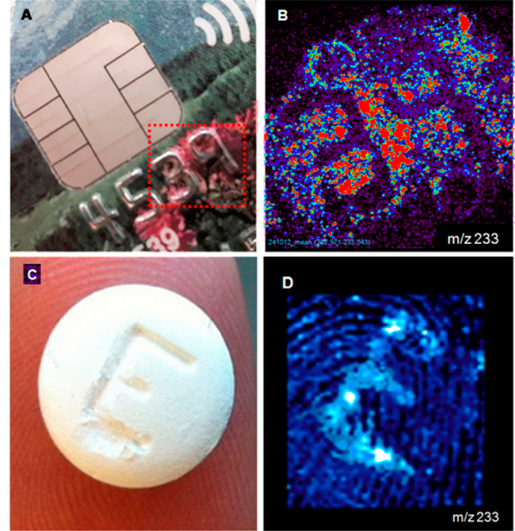
Figure 7. Details of chemical images on fingermarks from different objects. Caffeine residues on a credit card contaminated with it ( A ), and from a tablet ( C ), are visible on fingermarks ( B , D ), preserving the details of the object touched. MS images were flipped horizontally for clarity.